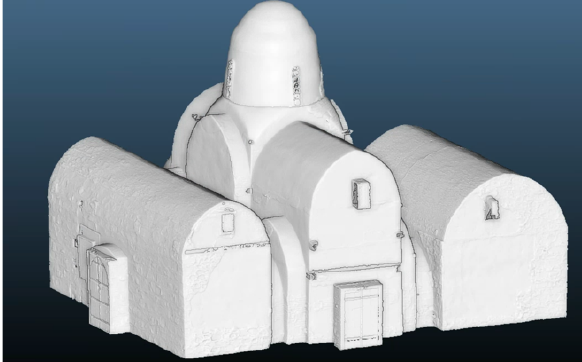
Figure 8. Timios Stavros, Pelendri, interior, shaded model.